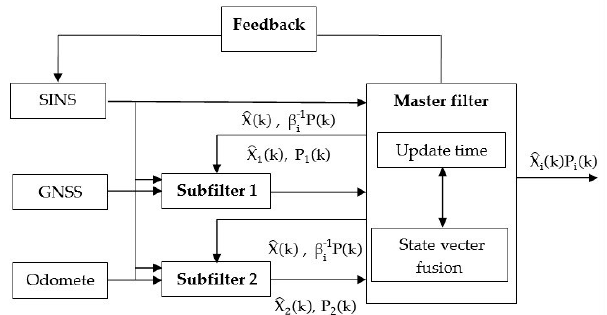
Figure 4. Federated filter architecture.